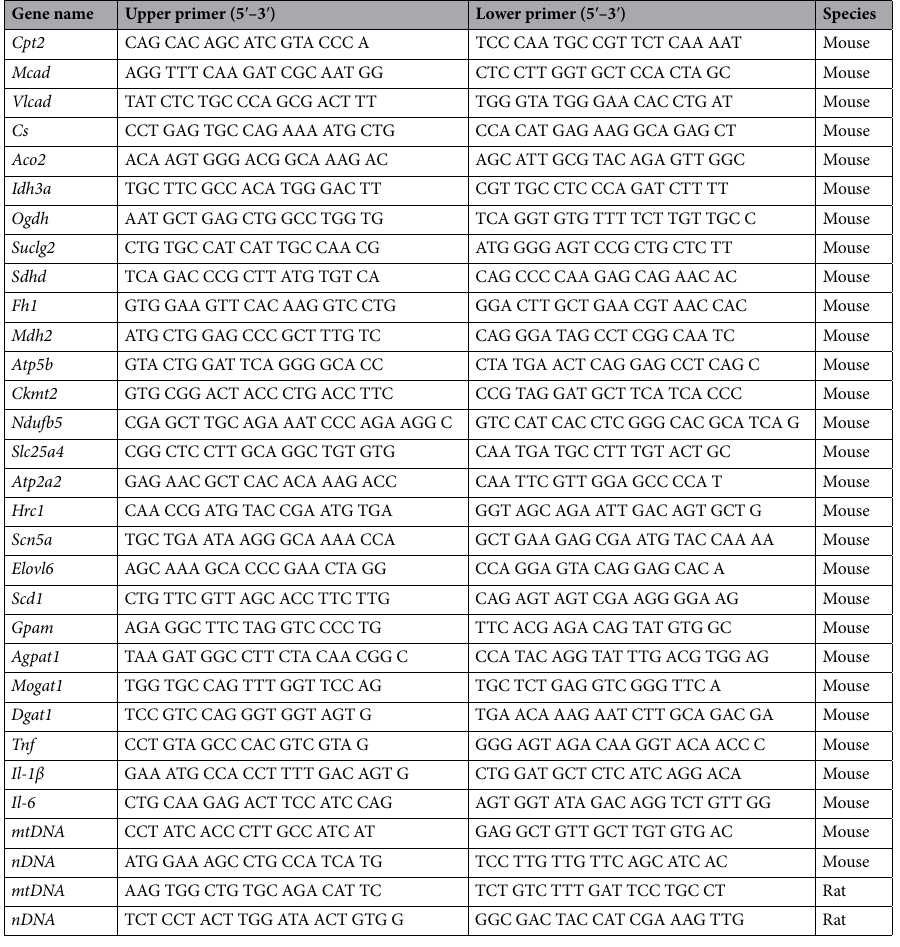
Table 1. Primers used for real-time